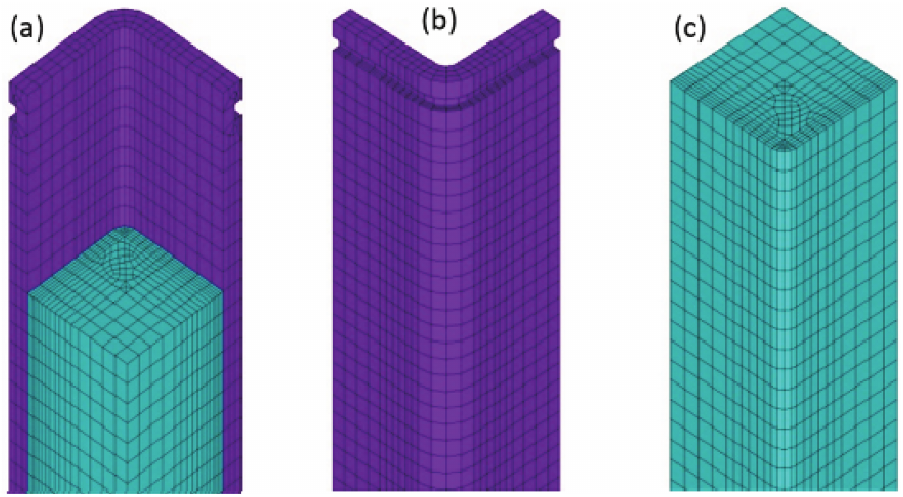
Figure 1: Three-dimensional finite-element model: (a) whole model, (b) mold model, and (c) billet